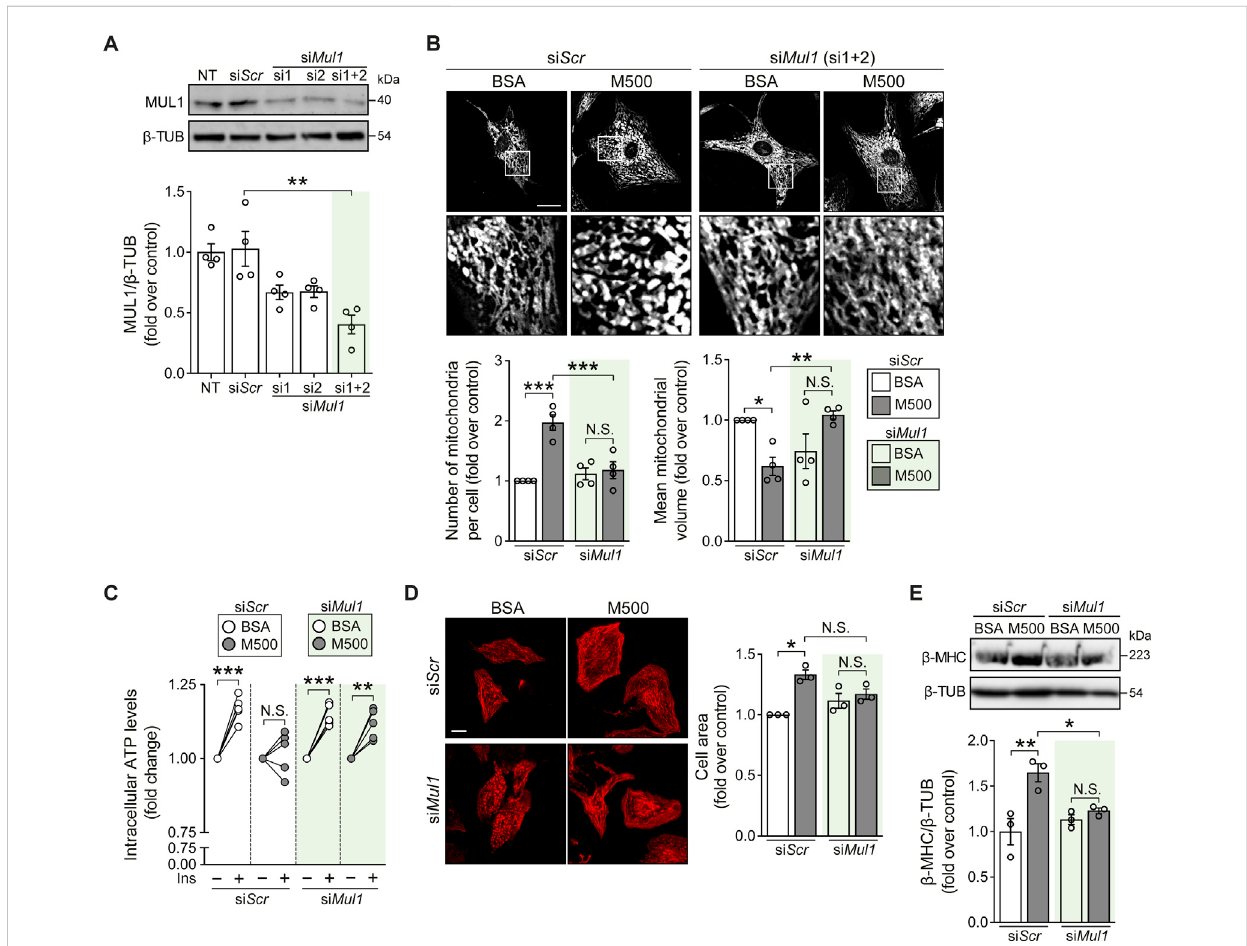
FIGURE 4 Mul1 -KD prevents myristate-induced cardiomyocyte hypertrophy and mitochondrial fragmentation. (A) Top : Representative immunoblot of MUL1, detected in NRVM treated with scrambled siRNA (si Scr ) or siRNA against Mul1 (si1 or/and si2). β -TUBULIN ( β -TUB) was used as a loading control. Bottom : Quanti fi cation of MUL1/ β -TUB (n = 4). (B) Top : Representative images of NRVM treated with scrambled siRNA (siScr) or Mul1 siRNA (si Mul1 ), incubated with BSA or myristate 500 μ M (M500) for 24 h and stained with MitoTracker Green to visualize the mitochondrial network. Scale bar = 10 μ m. Bottom :Quanti fi cationofmitochondrialnumberandaveragemitochondrialvolume(n=4). (C) MeasurementofintracellularATPlevels ofNRVM treated with scrambled siRNA (siScr) or Mul1 siRNA (si Mul1 ), incubated with BSA or myristate 500 μ M (M500) for 24 h and stimulated with insulin (Ins) 10 nM for 3 h, or non-stimulated (n = 5). (D) Left : Representative images of NRVM treated with scrambled siRNA (siScr) or Mul1 siRNA ( siMul1 ), incubated with BSA and myristate 500 μ M (M500) for 24 h and stained with rhodamine-phalloidin to evaluate cell area. Right : Quanti fi cation of cell area (n = 3). (E) Top : Representative immunoblot of β -MHC, detected in NRVM treated with scrambled siRNA (siScr) or Mul1 siRNA (si Mul1 ), incubated with BSA or myristate 500 μ M (M500) for 24 h β -TUBULIN ( β -TUB) was used as a loading control. Bottom : Quanti fi cation of β -MHC/ β -TUB (n = 3). In all panels: individual data points are shown, and bars represent mean ± S.E.M. Statistical comparisons: * p < 0.05, ** p < 0.01, and *** p < 0.01. N.S: non-signi fi